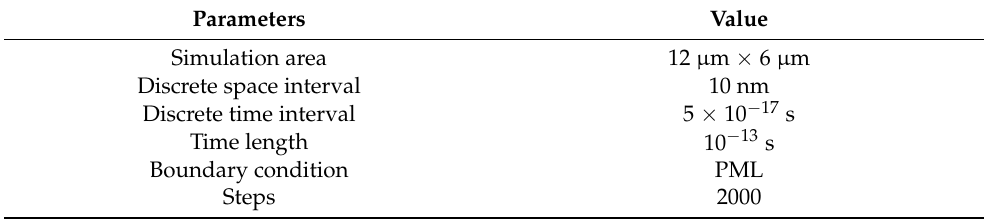
Table 3. FDTD simulation parameters.